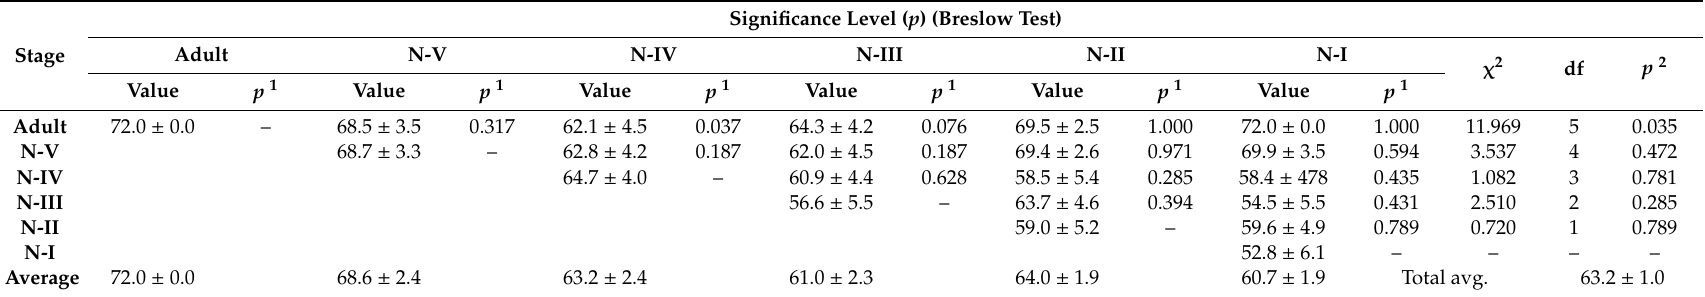
Table A5. Aggressiveness of Nesidiocoris tenuis cannibalism on di ff erent stage class, measured as survival time (hours) ( ± SE) when caged singly with other conspecifics for 72 h under laboratory conditions (25 ± 1 ◦ C and 60–80% RH) and without prey.